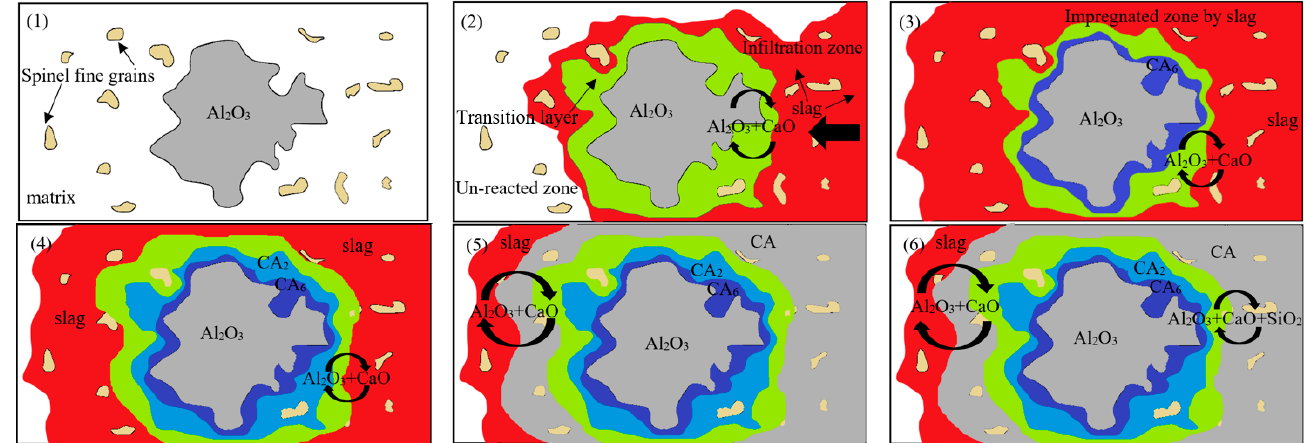
Figure 19. Model of corrosion mechanism of alumina-spinel refractory by metallurgical slag (green—transition layer in each corrosion stage, red—slag); (1) un-infiltrated Al-Sp microstructure, (2) first contact between CaO-Al 2 O 3 -SiO 2 (CAS) slag and Al-Sp refractory, (3) formation of CA 6 layer around alumina aggregates, (4) formation of CA 6 , CA 2 layers (5) formation of CA 6 , CA 2 , and CA layers according to precipitation-dissolution mechanism.